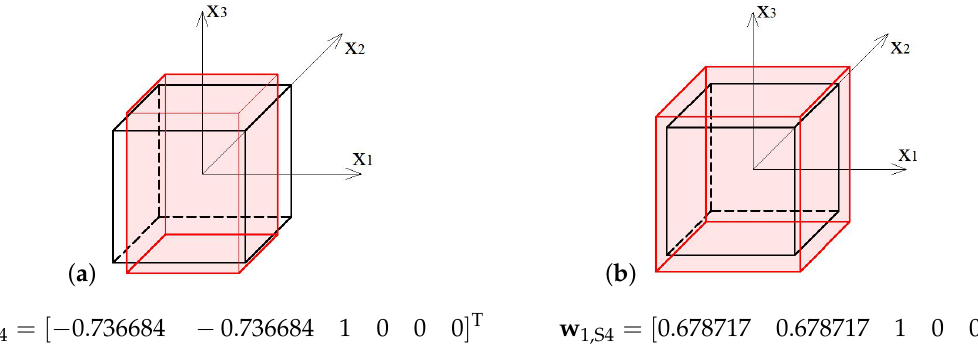
Figure 6. Deformation modes of the 4-strut simplex: ( a ) Soft mode. ( b ) Stiff mode.